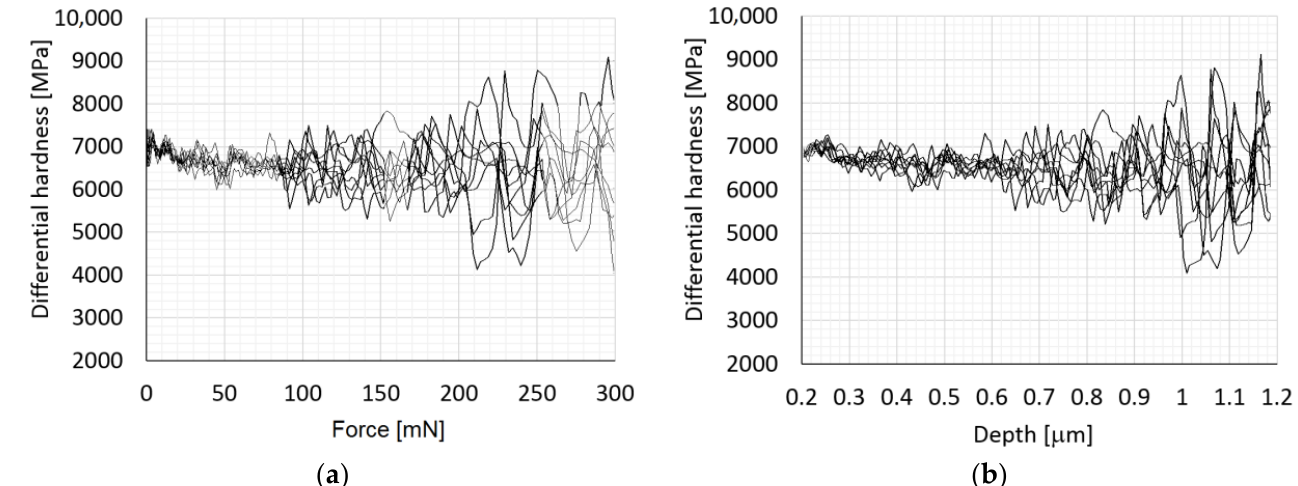
Figure 8. Dependence of differential hardness on ( a ) force, ( b ) depth.